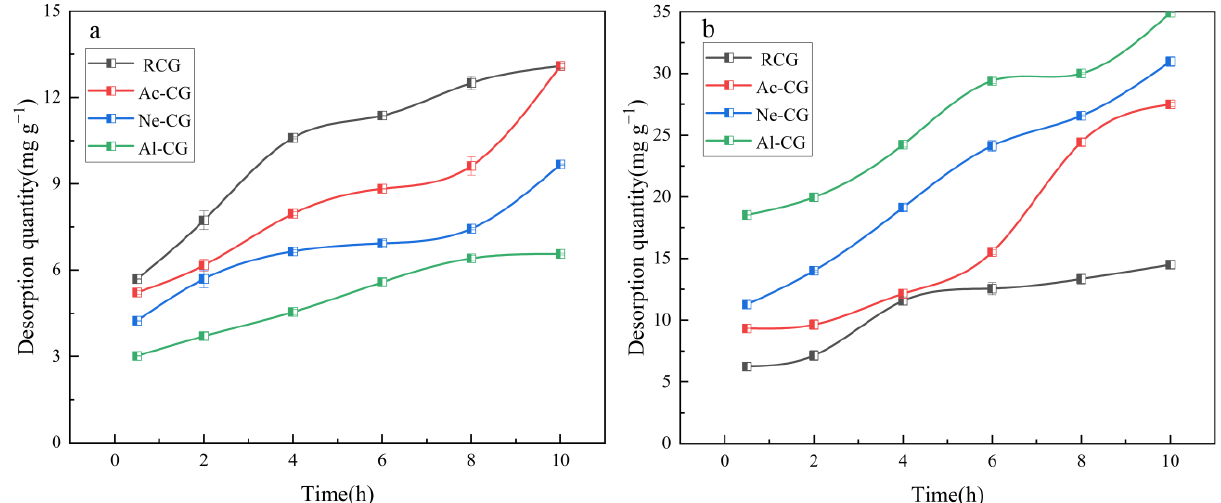
Figure 5. Desorption curves of coal gangue samples toward phosphate under different times; the desorbents are distilled water ( a ) and NaHCO 3 solution ( b ) respectively, and the coal gangue samples are those that have absorbed phosphate for 40 h in the adsorption kinetics experiment. Error bars represent standard error of the mean ( n = 3).